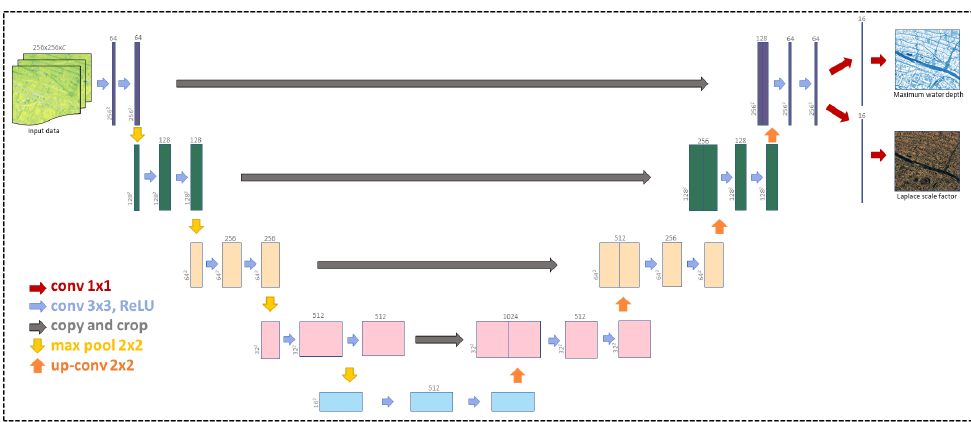
Figure A1. Illustration of the U-Net architecture as used in this